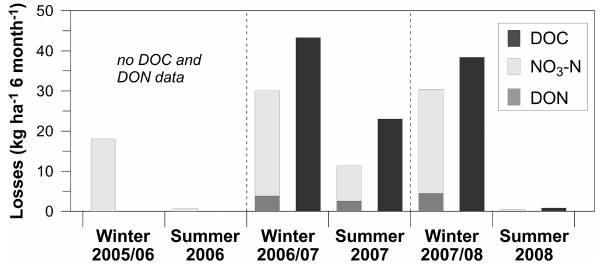
Figure 6. Seasonal losses of dissolved organic carbon (DOC), dis- solved organic nitrogen (DON) and nitrate–nitrogen (NO 3